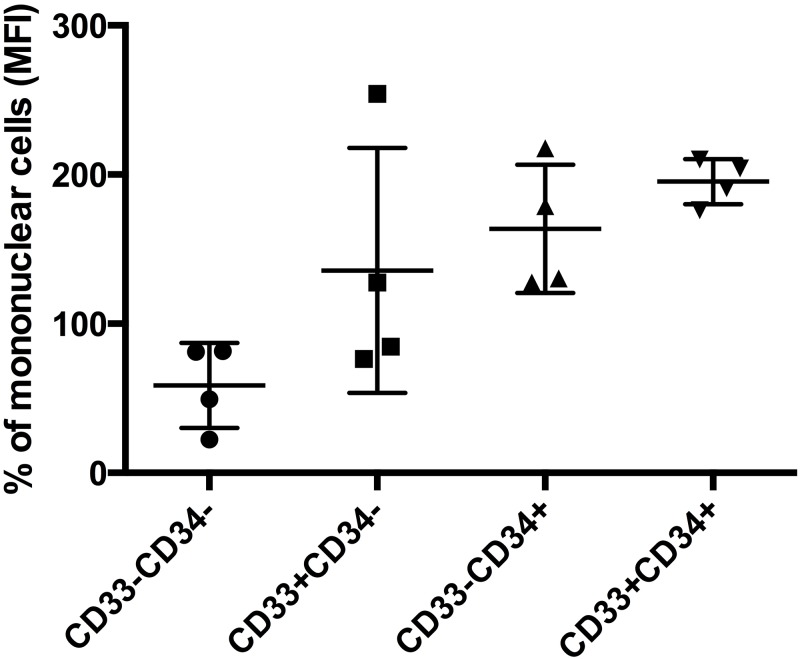
IGF-1R expression is mostly from CD34+ and CD33+cell population.Four PV patients with elevated IGF-1R were studied. Flow cytometry analysis was done to investigate which cell populations produce IGF-1R. Setting IGF-1R (MFI) of mononuclear cell population values as 100%, CD33-CD34- cells were found to be 58±14%; CD33+CD34-, 135.7±41%; CD33-CD34+, 163.6±21.5%; CD33+CD34+,195.3±7.5%. Therefore, IGF-1R expression was mostly from CD34+ and CD33+ cell populations.